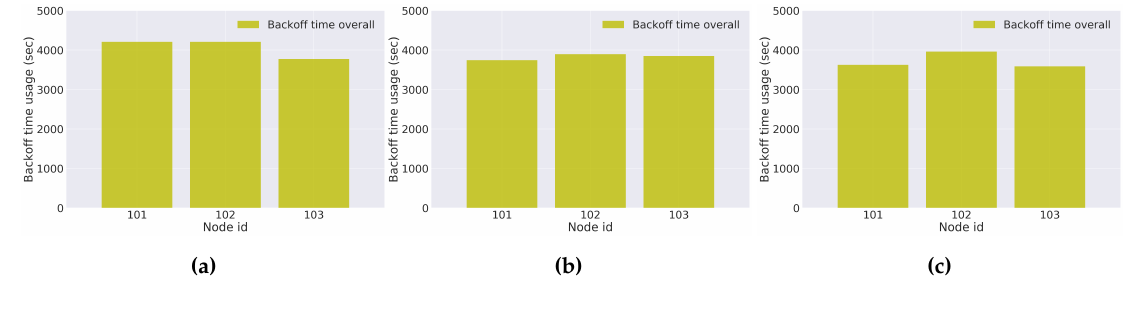
Figure 16. Overall backoff usage ( a ) Day 1; ( b ) Day 2; ( c ) Day 3.